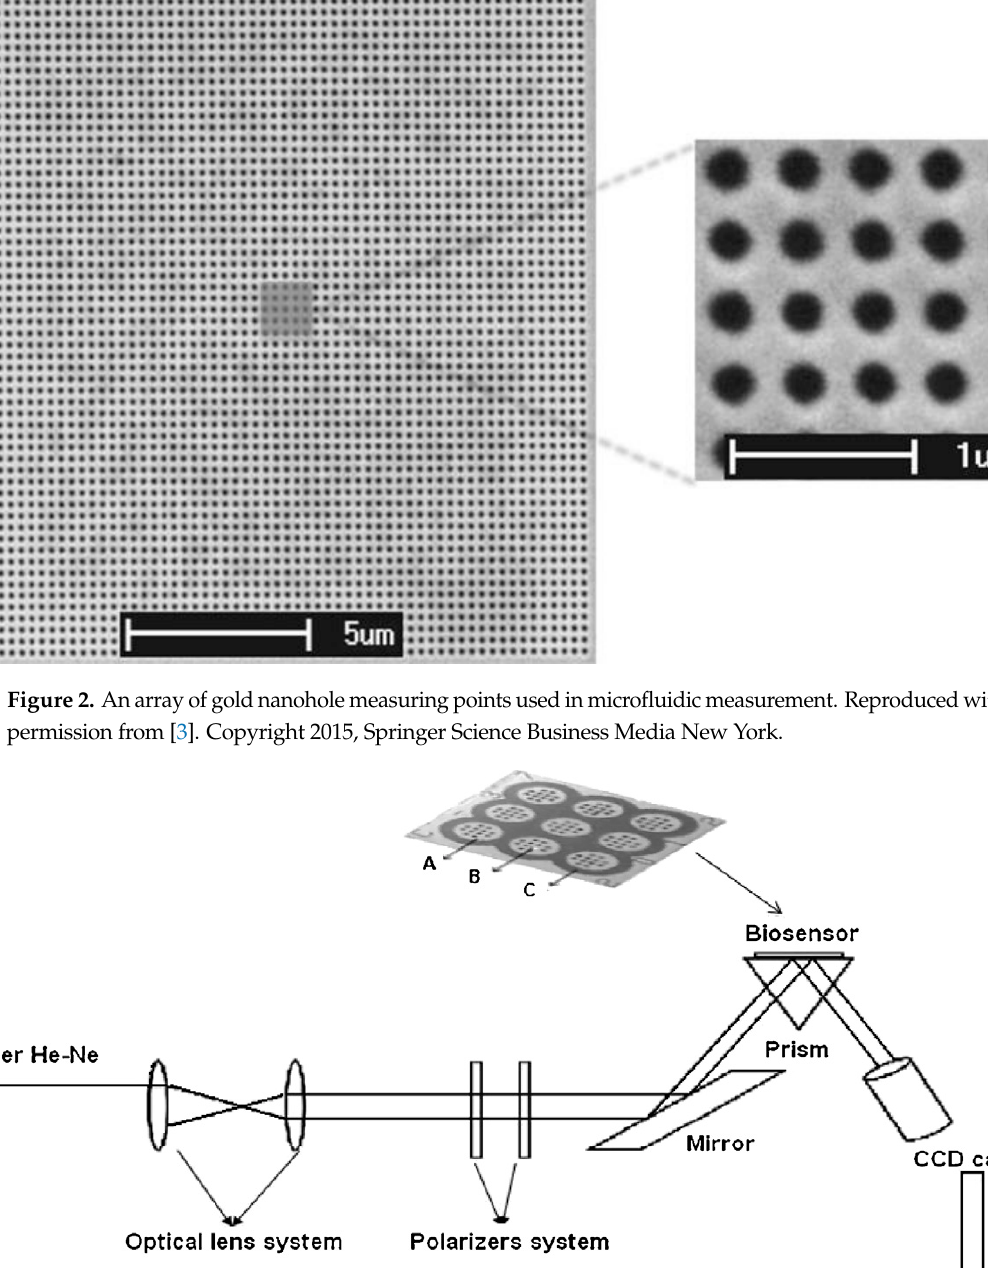
Figure 3. Example of non-fluidic measurement. Reproduced with permission from [27]. Copyright 2017 Elsevier